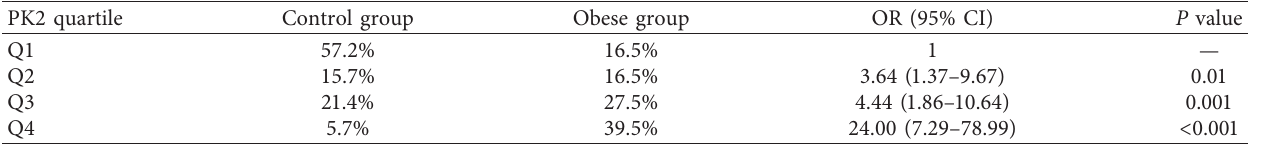
Table 4: Distribution of patients according to PK2